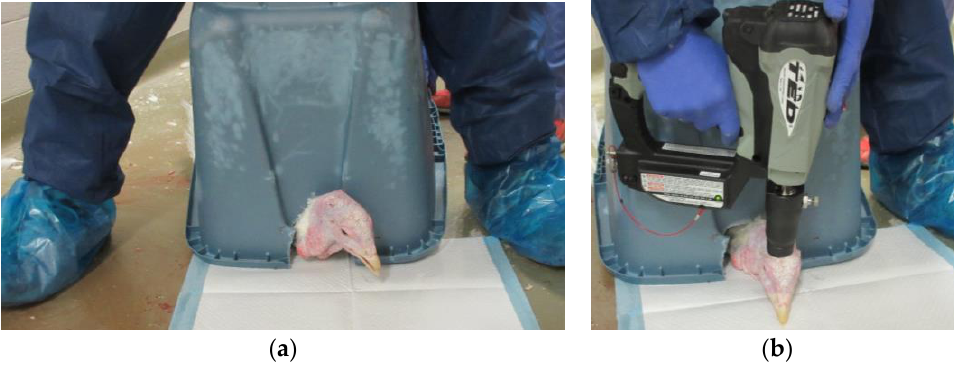
Figure 3. An example of the restraint method ( a ) and correct placement of the device ( b ) during the euthanasia trial.